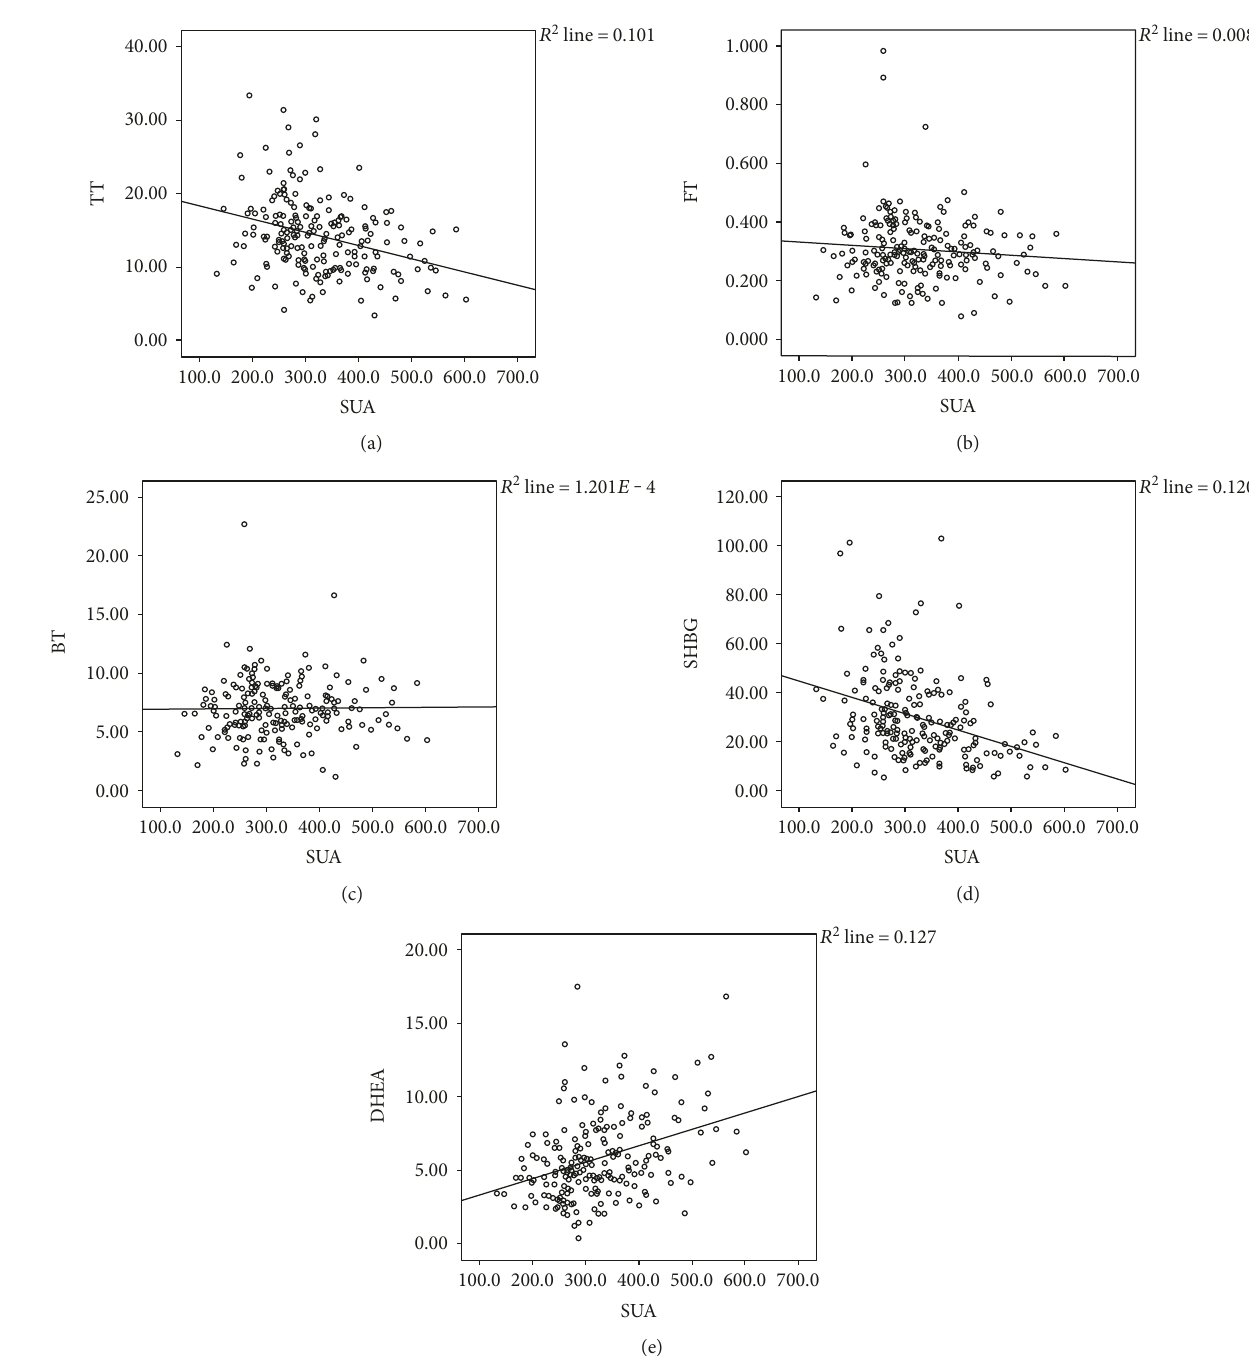
Figure 2: Hormone scatter diagram. Scatter plot showing correlation of SUA levels with TT, FT, BT, SHBG, and DHEA. With the rise of SUA, TT, and SHBG decreasing signi fi cantly, DHEA signi fi cantly increased. SUA levels showed a negative correlation with TT and SHBG levels ( r = − 0 308 , p < 0 001 and r = − 0 379 , and p < 0 001 , resp.) and a positive correlation with DHEA ( r = 0 352 , p < 0 001 ), FT ( r = − 0 090 , p = 0 199 ), and BT ( r = 0 011 , p = 0 876 ) levels. TT: total testosterone; BT: bioactive testosterone; FT: free testosterone; E2: estradiol; SHBG: sex hormone-binding globulin; DHEA: dehydroepiandrosterone; SUA: serum uric